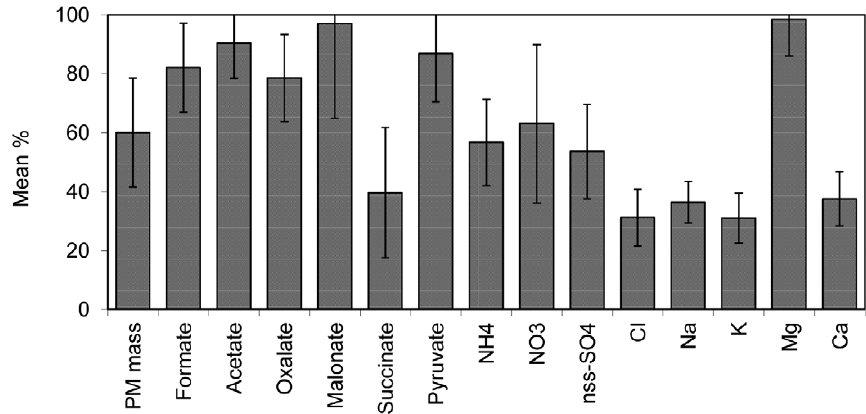
Fig. 3 - Mean fine (PM2.5) to PM10 percentage ratio and associated standard deviation for the PM mass, carboxylate and water-soluble ions from